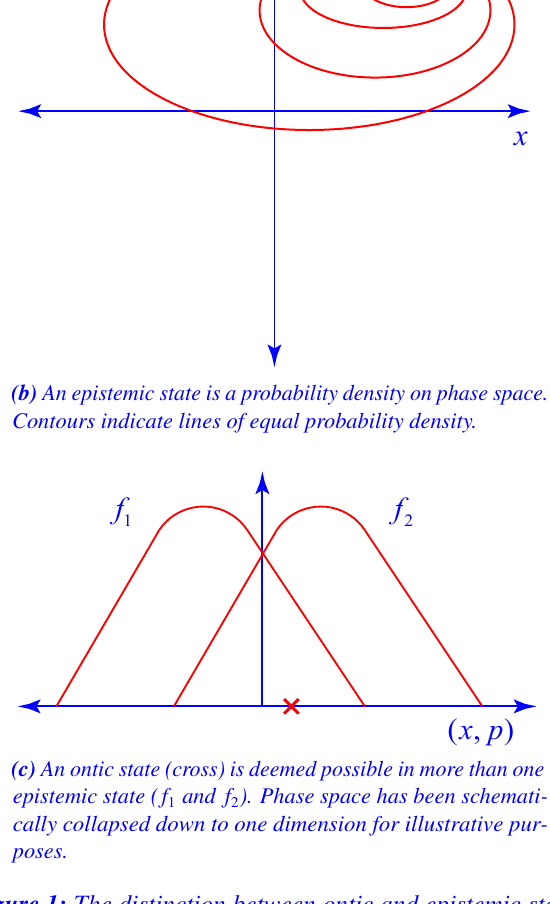
Figure 1: The distinction between ontic and epistemic states in single particle classical